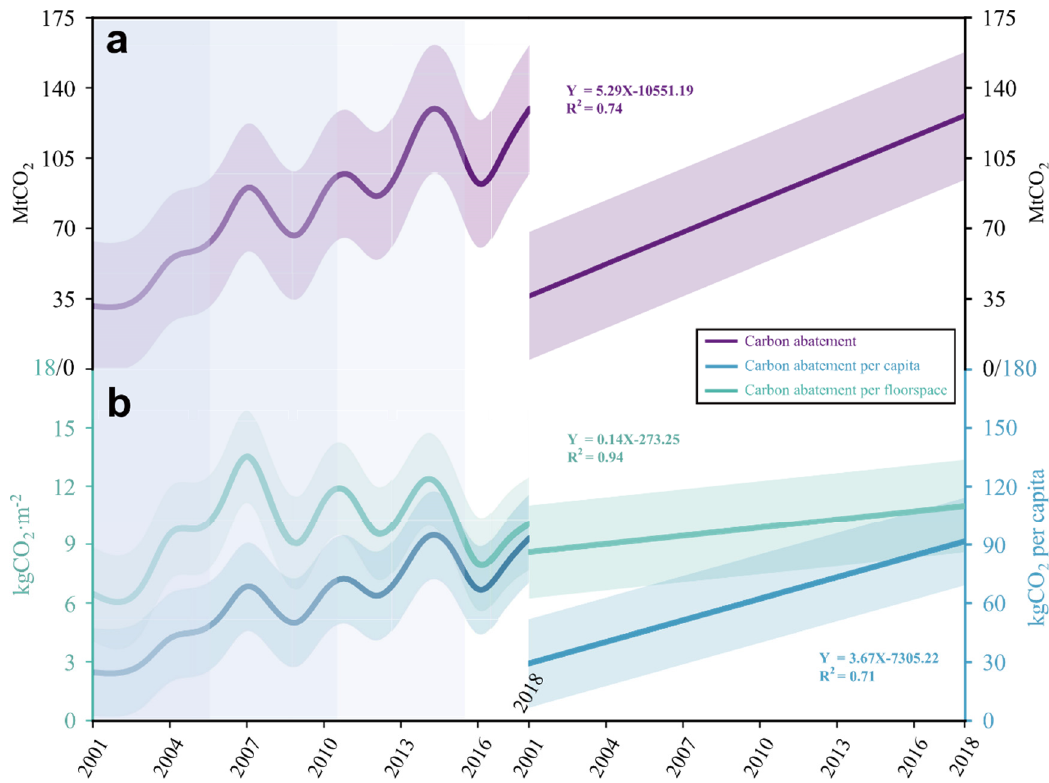
Figure 3. Emissions abatement from commercial building operations at the levels of ( a ) total abatement and ( b ) abatement per floor space and per capita.